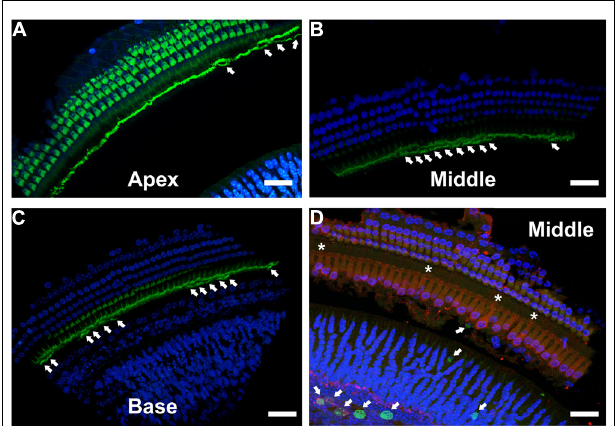
FIGURE 12 | Immunohistochemical localization of stereocilia and proliferating cells on DN-CBRb + / ROSA-CAG-rtTA + mouse cochleae. (A–C) Phalloidin (green) staining of P10 CBRb + / ROSA-CAG-rtTA + mouse cochlea revealed the presence of F-actin-positive stereocilia-like structures (arrows). Due to the peculiar cochleae anatomy, (B,C) were rotated to facilitate visualization of the stereocilia. (D) EdU (green) labeling in DN-CBRb + / ROSA-CAG-rtTA + (CBRb) at P10 showed no proliferation within the OC; however, a few EdU-positive cells were observed at the greater epithelial ridge. Asterisks indicate supernumerary cells. DAPI = Blue; MyosinVIIa = Red. Bar = 10 μ